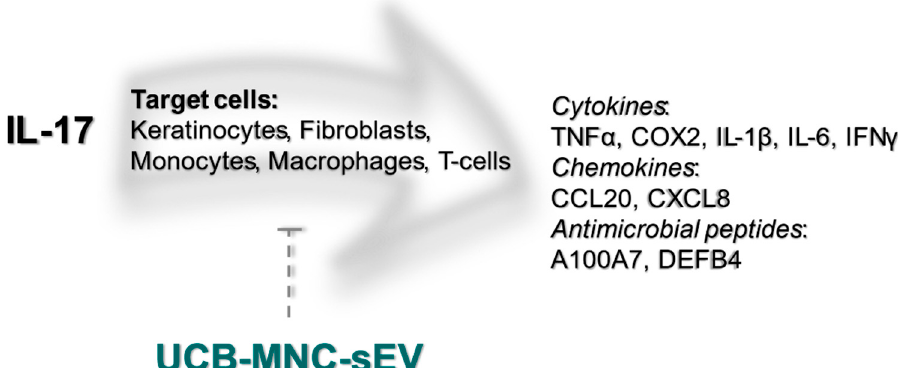
Figure 5. UCB-MNC-sEV’s putative effect on the IL-17 signaling pathway. IL-17, particularly IL-17A, is thought to be a crucial driver of psoriatic disease. IL-17 target cells include keratinocytes, fibroblasts, monocytes, macrophages, and T-cells, all of which are likewise targeted by UCB-MNC-sEV, either directly or indirectly. As shown in this paper, treatment with UBC-MNC-sEV affects multiple players of the IL-17 cascade, and results in a lower expression and/or release of psoriasis-associated mediators, such as TNF α , COX2, IL-1 β , IL-6, IFN γ , CCL20, CXCL8, A100A7 and DEFB4.